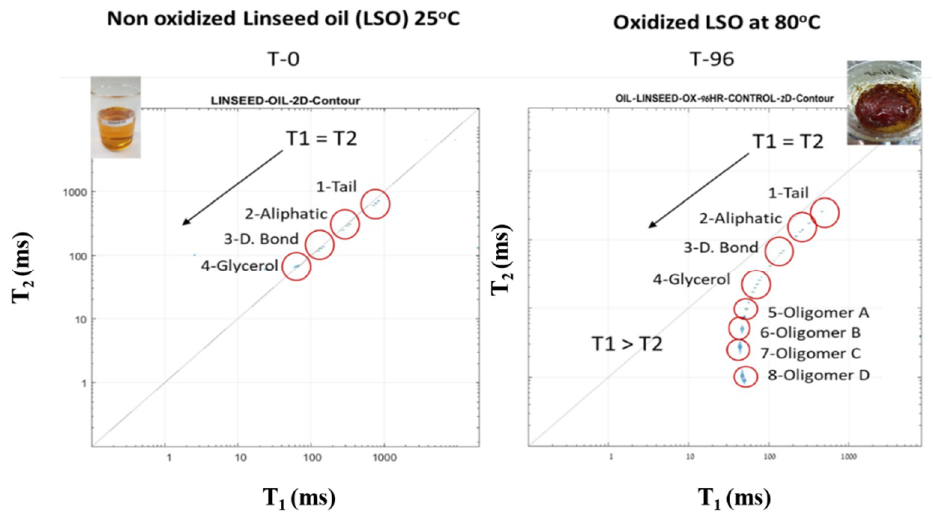
Figure 12. Two-dimensional T 1 -T 2 fingerprint mapping of LSO before (T-0) and after 96 h of heating at 80 ◦ C. Reprinted Figure 12. Two‐dimensional T 1 ‐T 2 fingerprint mapping of LSO before (T‐0) and after 96 h of heat‐ with permission from ref. [27]. Copyright 2019 ing at 80 °C. Reprinted with permission from ref. [27]. Copyright 2019 Wiley.